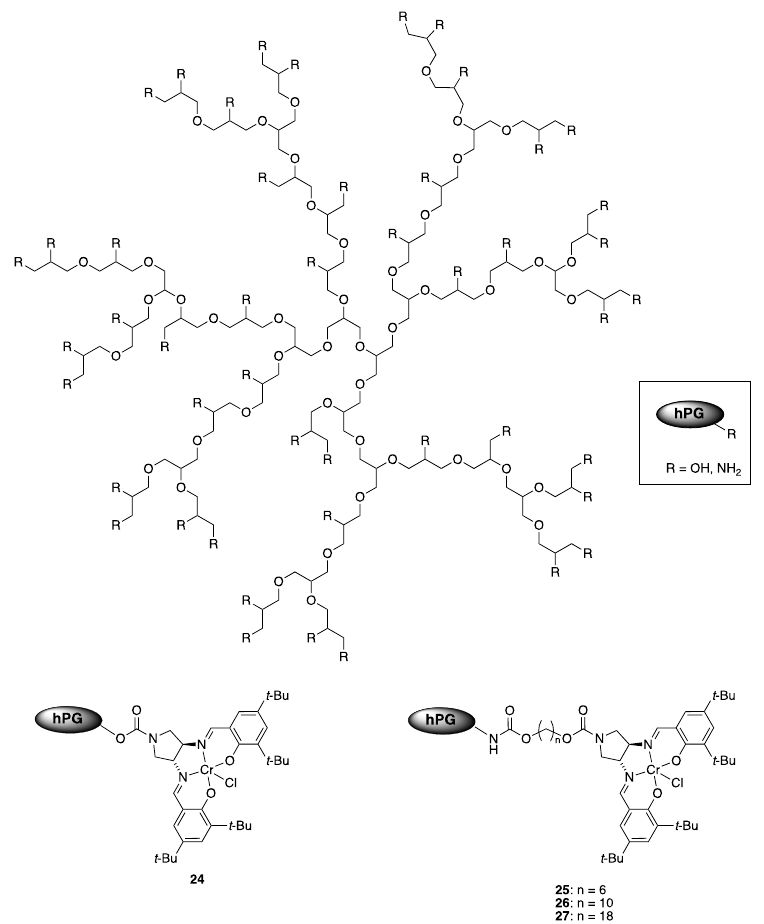
Figure 8. Cr–salen complexes immobilized on hyperbranched polyglycerol (hPG).